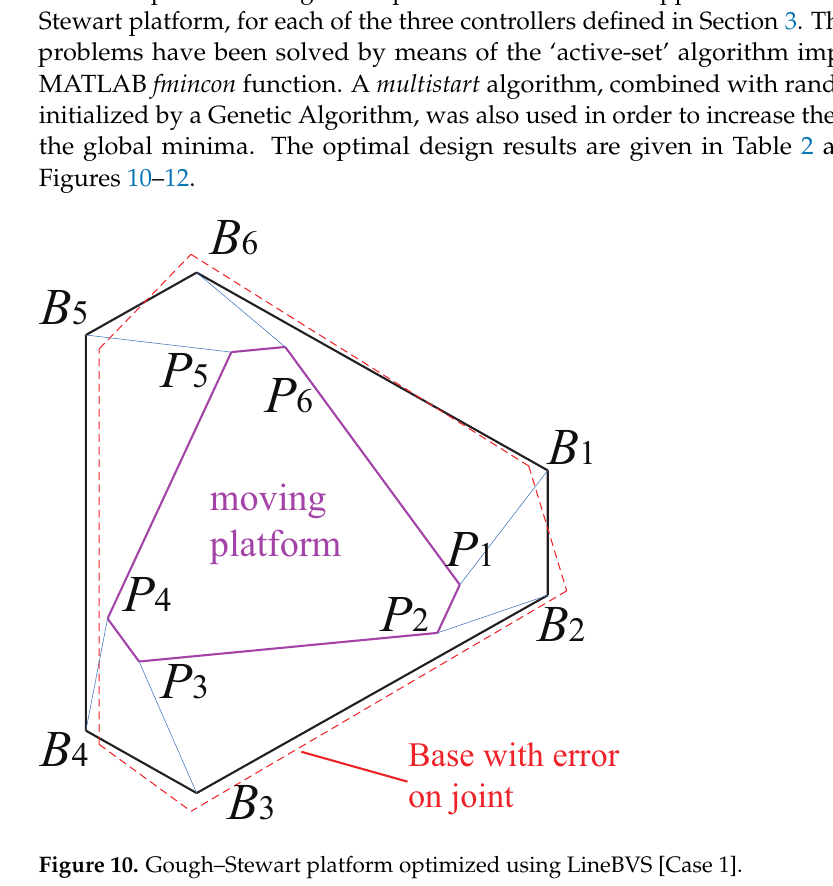
Figure 10. Gough–Stewart platform optimized using LineBVS [Case 1].